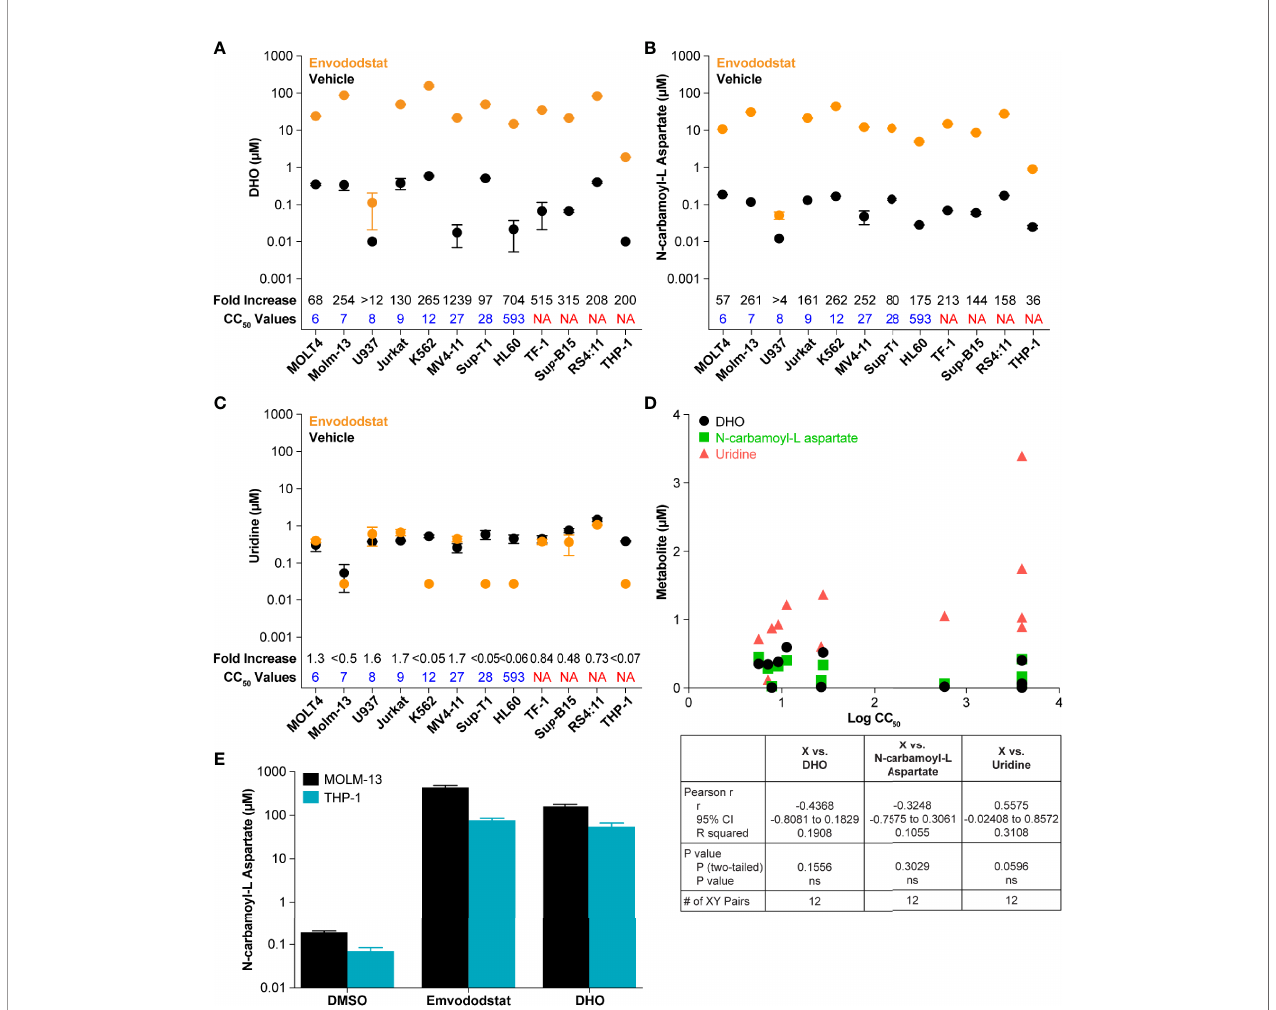
FIGURE 2 | The fi gures show baseline (untreated) and post-treatment levels for the metabolites DHO (A) and N-carbamoyl-L-aspartate (B) , and uridine (C) following treatment with 1 µM emvododstat. Included for each cell line is the CC 50 just above the x-axis and the fold increase (treated/untreated) measured in each cell line at the top of the graph. Values represent the mean ± SD for 3 replicates. (D) Shown are the baseline levels of DHO, N-carbamoyl-L-aspartate, and uridine vs the log CC 50 values. Below the graph are the correlation statistics calculated using Prism (GraphPad). (E) Shown are levels of N-carbamoyl-L-aspartate measured in MOLM- 13 or THP1 cells after 4 h of incubation with 1 µM emvododstat or with 10 mM DHO. Where levels of a measured metabolite were below the lower limit of quanti fi cation (LLOQ), a value of LLOQ/2 was used for subsequent